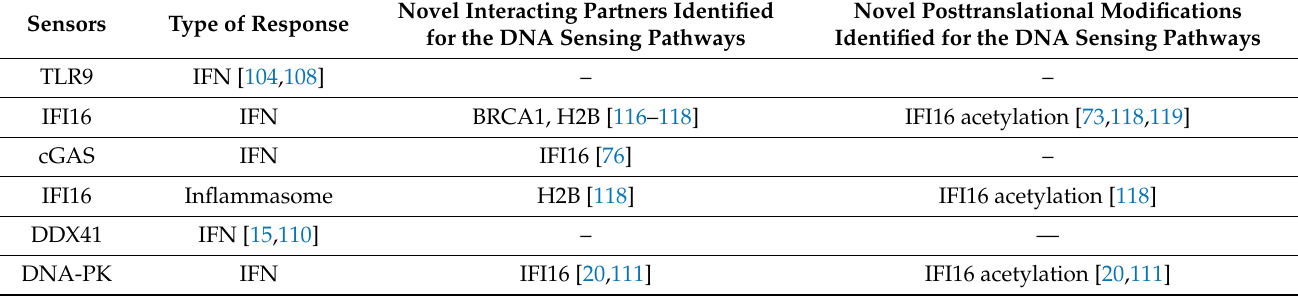
Table 1. Important highlights in the innate immune sensing of herpesvirus genomes. Here, the DNA sensors that have been shown to play a role in herpes genomes sensing and the type of response they induce are presented. In addition, novel molecules or novel posttranslational modifications that have been found to play a role in the DNA sensing pathways are also shown. Dotted line (–) indicates absence of